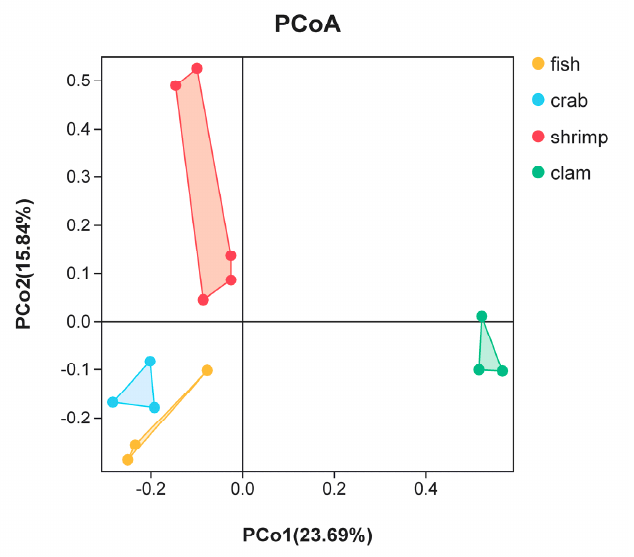
Figure 3. Principal coordinate analysis (PCoA) of bacterial community differences in the intestines of different aquatic animals.